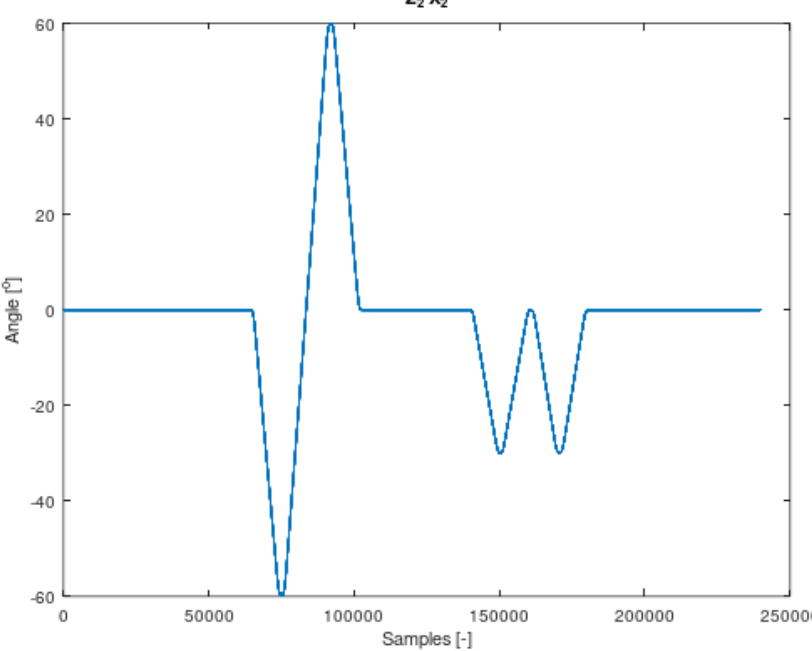
Figure 5. The angle set on the robot axis to which the coordinate system is assigned z 2 x 2 in Figure 3. Data from FANUC robot encoders collected using the apparatus.